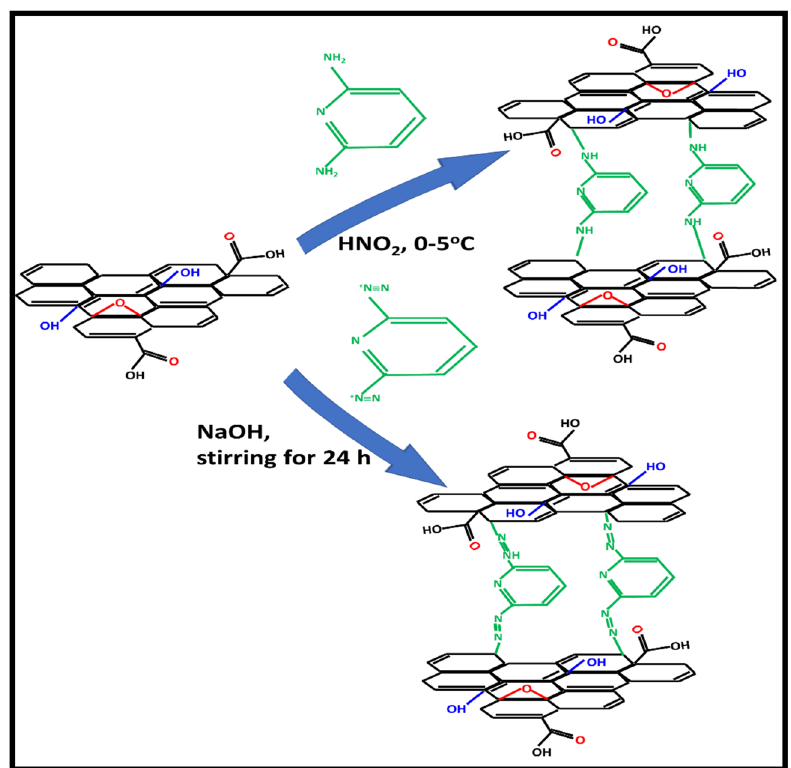
Figure 13: Schematic representation of the synthesis of pyridine - based functionalized GOs [ 128 ]